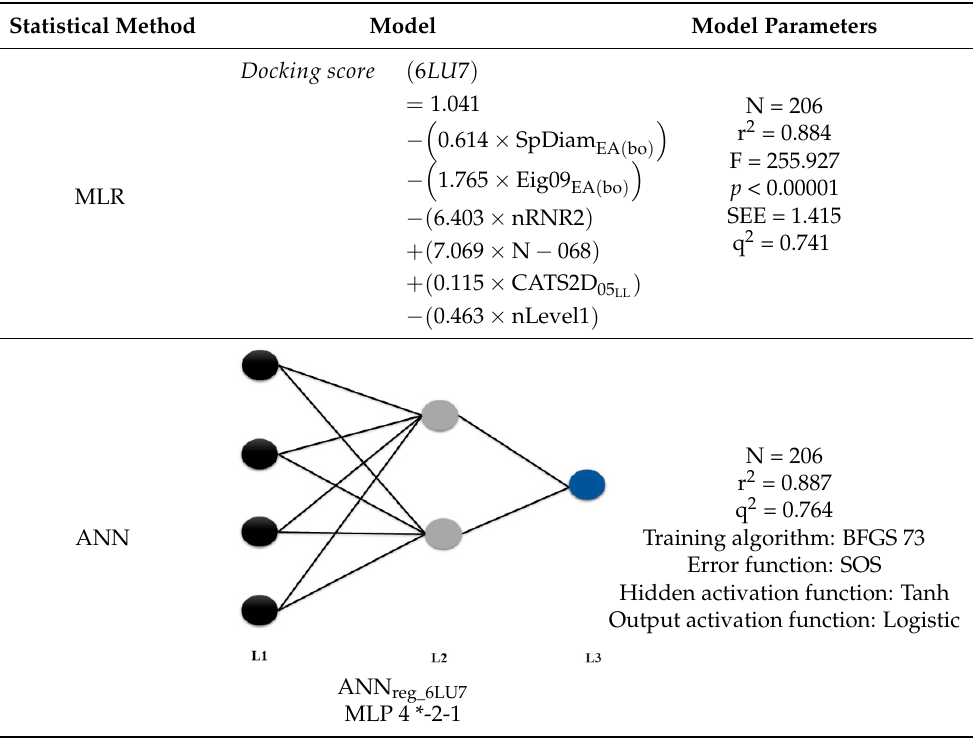
Table 3. Regression models developed to predict docking score against protease 6LU7 of SARS-CoV-2.